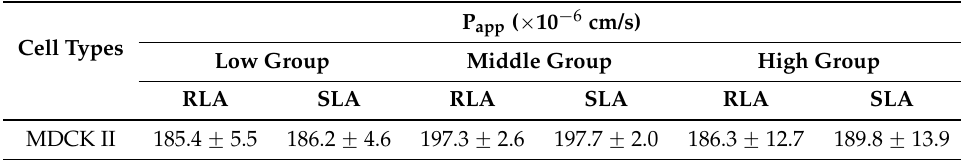
Table 4. Calculated P app of Mardin-Darby canine kidney II cell by using the value of 15 min after addition of α -lipoic acid.